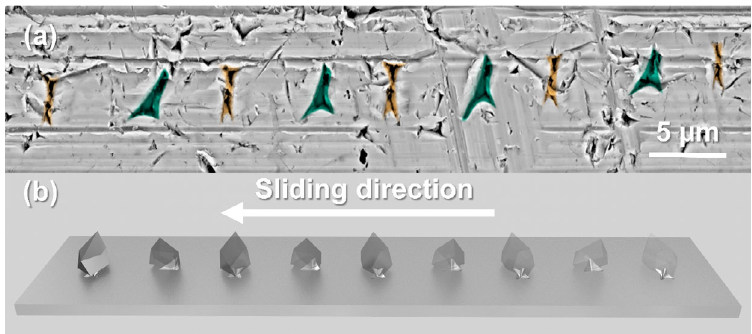
Fig. 9 Periodic pattern of indents: (a) SEM image of a disc after 50 m of sliding at 400 mm/s, and a periodic pattern of indents can be observed; (b) schematic of periodic indentation generation in